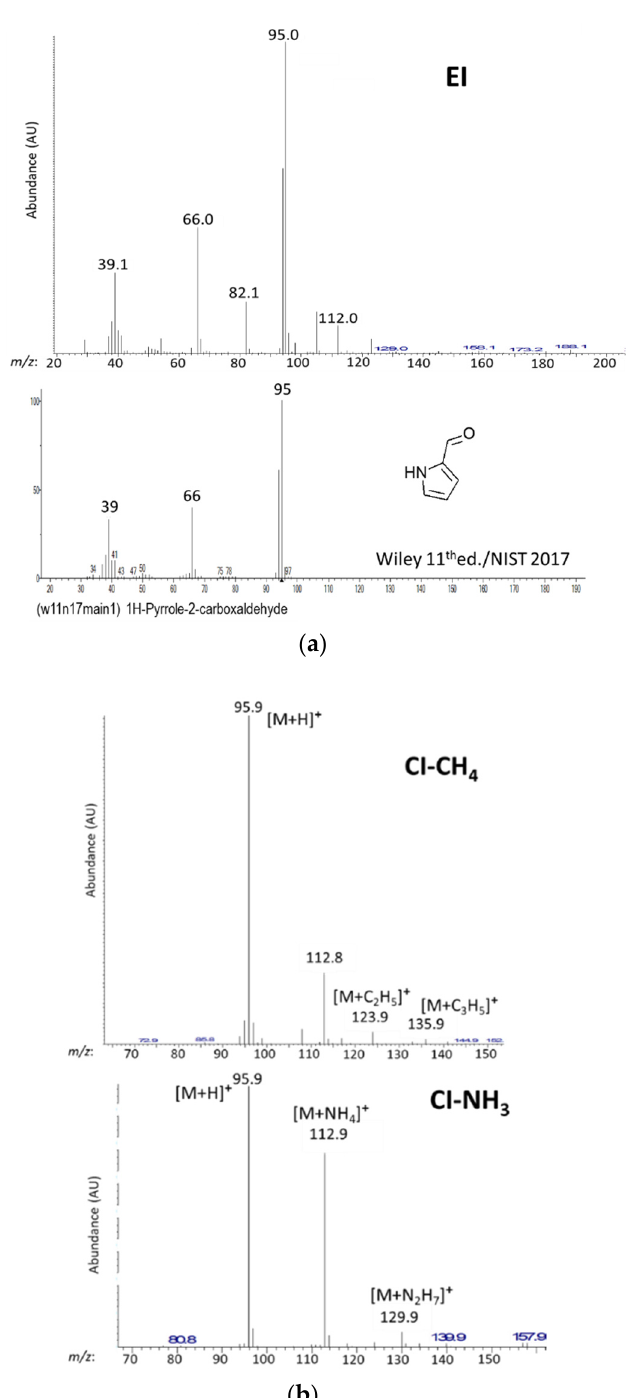
Figure 3. Mass spectra of 1H-pyrrole-2-carbaldehyde (OA n°69, MW 95) obtained in EI compared to the Wiley 11th Edition/NIST 2017 database reference spectrum ( a ) and in CI with methane and ammonia as reagent gases ( b ). Diagnostic ions on both CI spectra are indicated ( b ).